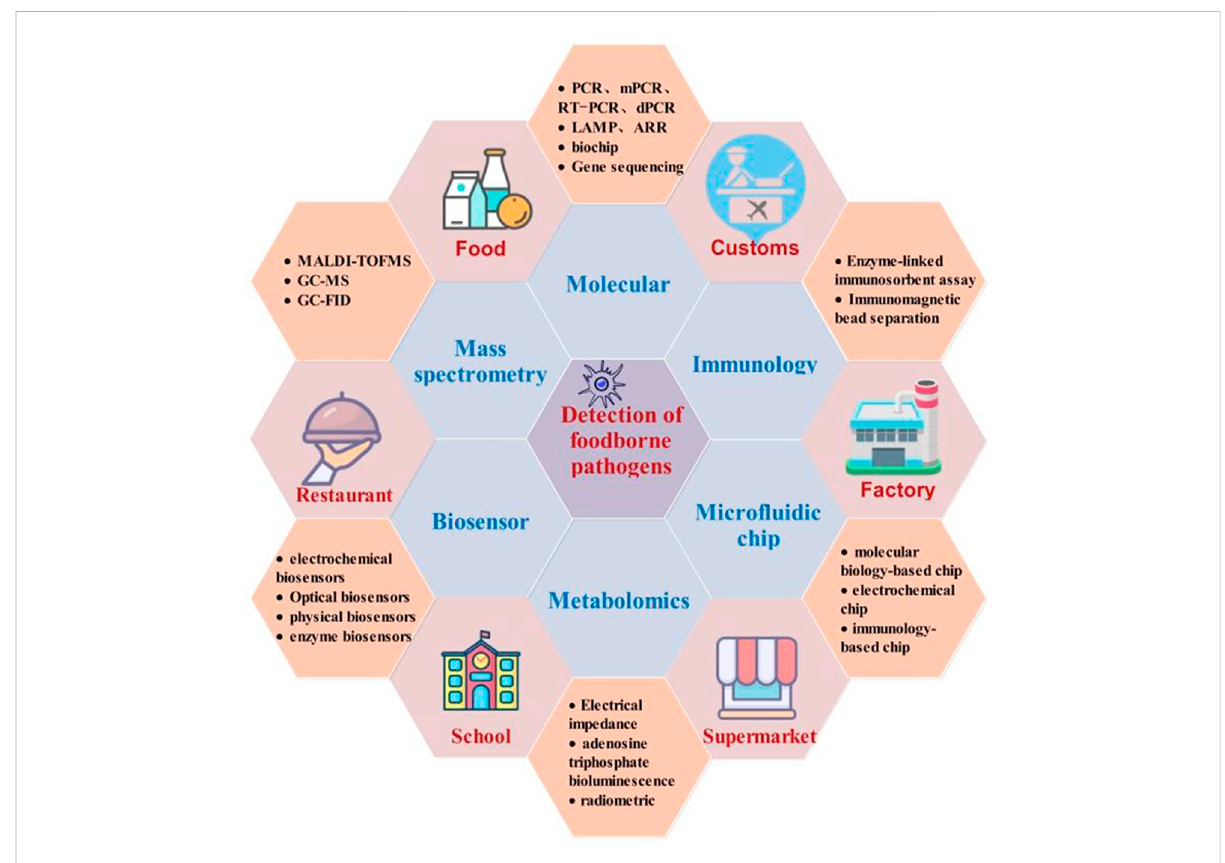
FIGURE 1 Summary based on detection methods of foodborne pathogenic